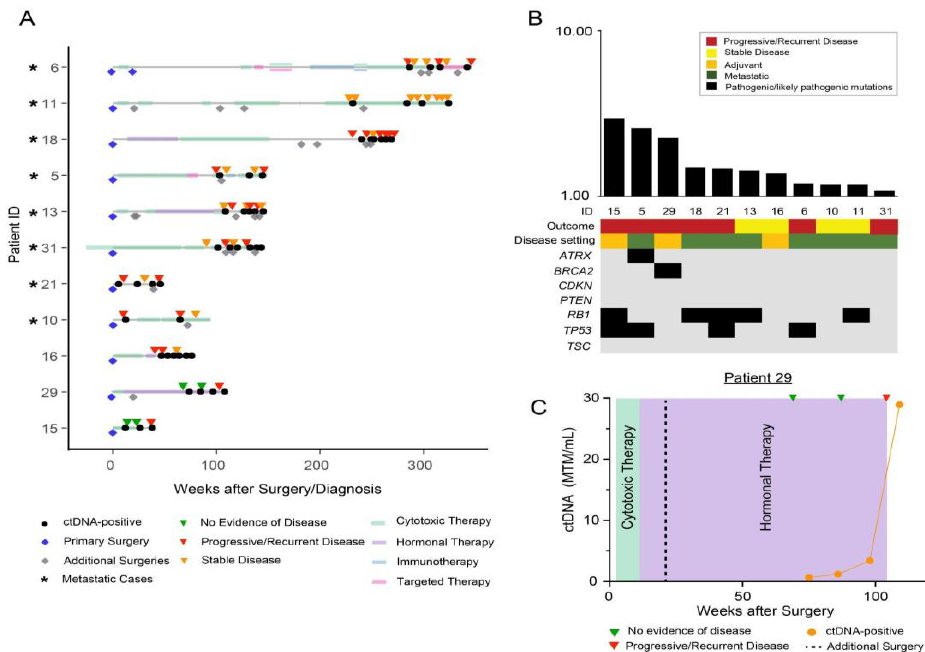
Figure 3. ( A ) Overview plot depicting the complete clinical course of all patients within sub-cohort C, including the results of longitudinal ctDNA analysis. Patients with metastatic disease are marked with an asterisk “*” symbol. Blue diamond reflects initial/primary surgery performed to build the personalized ctDNA assay, all other additional surgeries are represented with grey diamonds. ( B ) Distribution of pathogenic and likely pathogenic driver mutations across all 11 patients in sub-cohort C. ( C ) Clinical course for patient #29 who underwent an initial robotic supracervical hysterec-